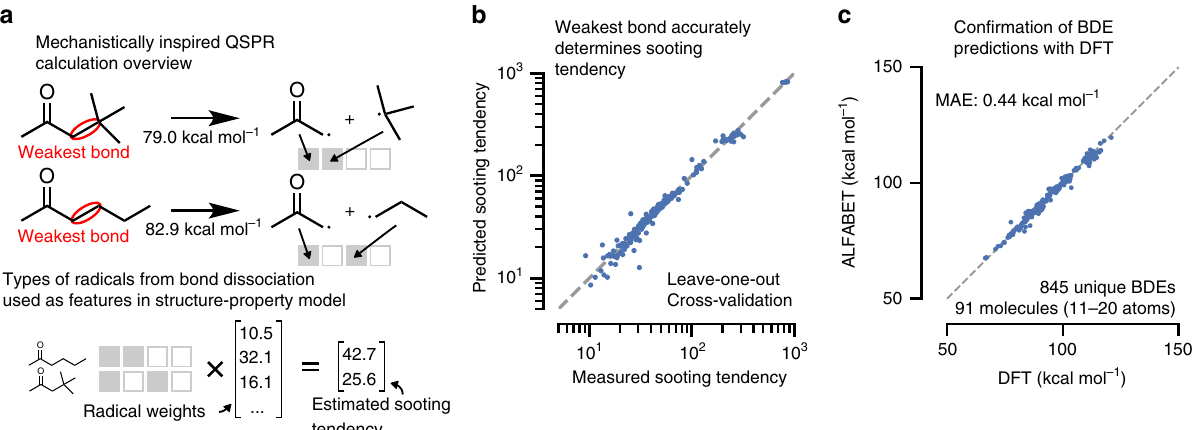
Fig. 8 Development of a model for sooting tendency based on fast BDE calculation. a Overview of the QSPR approach. ALFABET predictions are used to determine a molecules weakest bond, which identi fi es the radicals used as features in the QSPR. b Results of the QSPR model under leave-one-out cross- validation. The model achieves a superior accuracy to a previous group-contribution method. c Con fi rmation of the predictions for molecules larger than those included in the